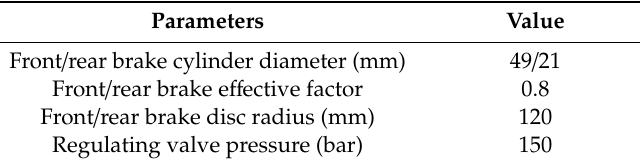
Table 4. Key parameters of front and rear wheel